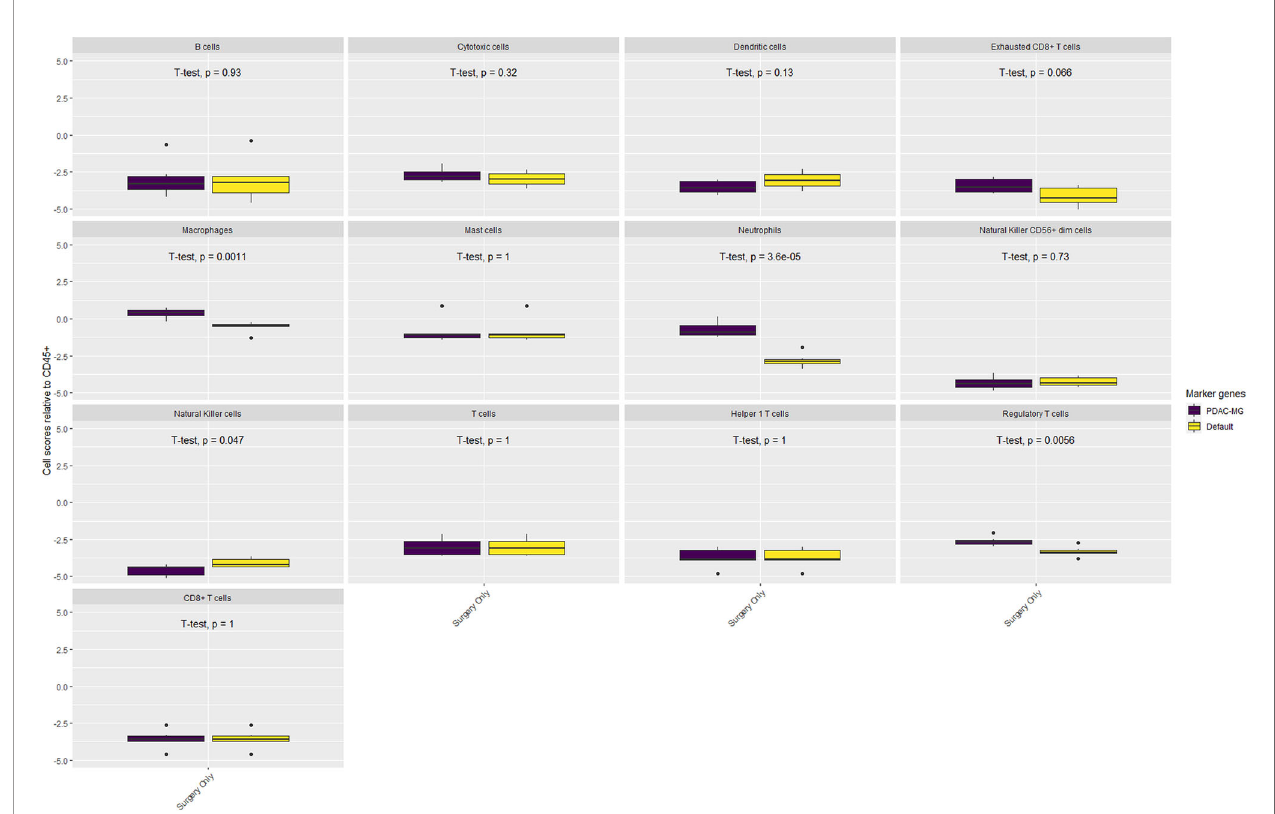
FIGURE 4 | The impact of using PDAC-MGICs to identify immune cells in PDAC tissue samples. Comparing the relative immune scores using mRNA expression data of 6 tissue samples of patients who were subjected to surgery before receiving any treatment (Surgery Only). Immune cells were identi fi ed using the PDAC- MGICs set (purple) or the default marker genes in nSolver ® Advanced Analysis module of NanoString technology (yellow). All cell types were relative to the total in fi ltration of CD45+ expression. Identifying immune cells based on the PDAC-MGICs shows a signi fi cant variation ( p-value < 0.05) in Macrophages, Neutrophils, Natural Killer cells, and Tregs